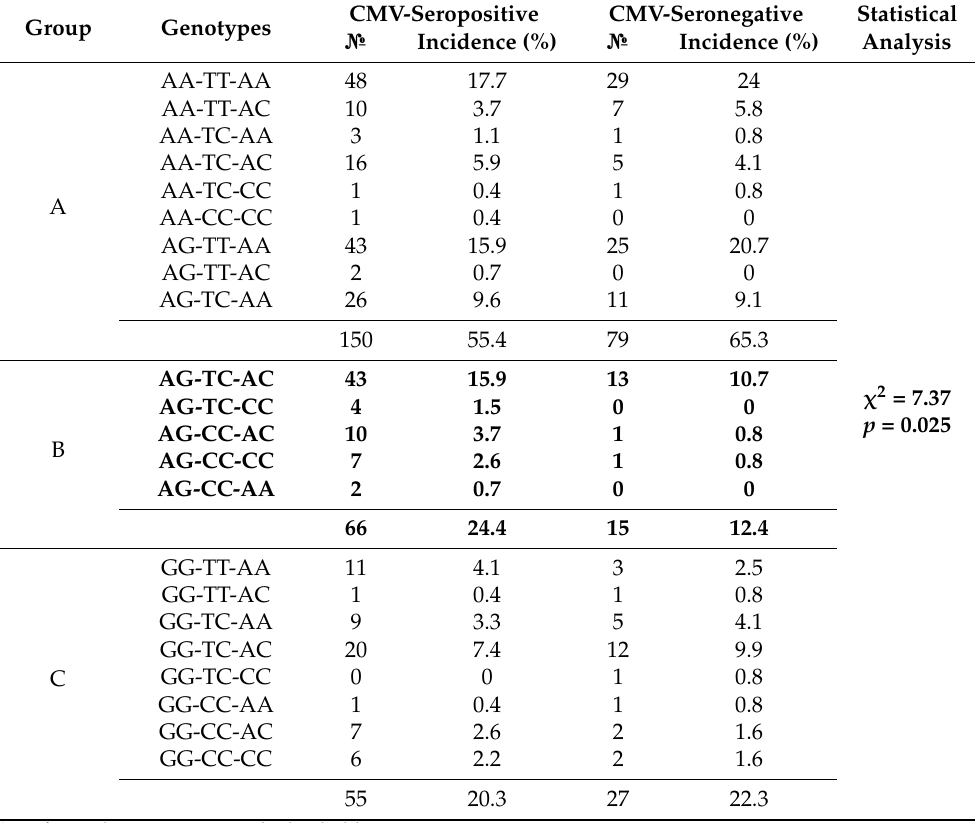
Table 2. Interaction of rs4693608, rs4364254 and rs4426765 in CMV-seropositive and CMV- seronegative healthy